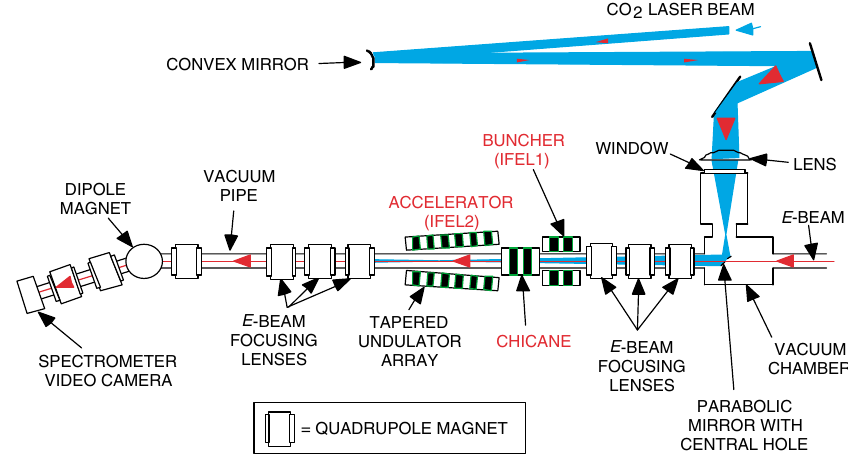
FIG. 1. (Color) Schematic layout of the STELLA-II experiment at the BNL